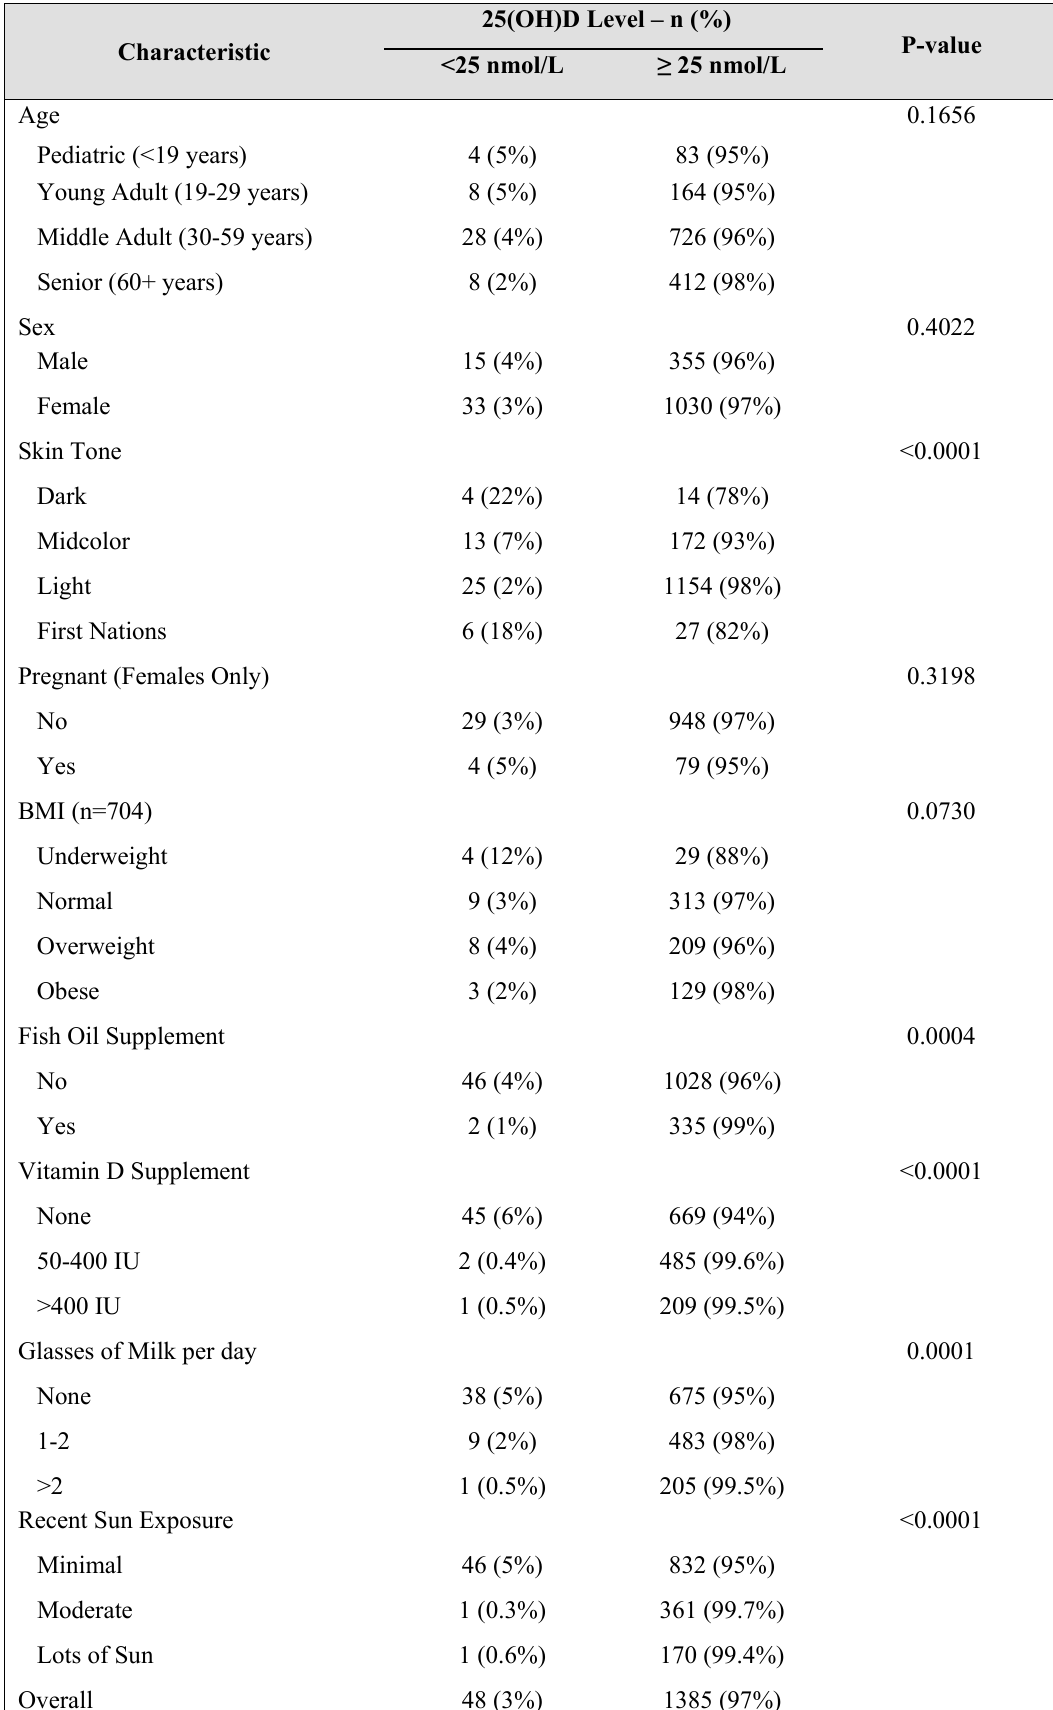
Table 6. Severe Vitamin D Deficiency by Demographic and Lifestyle